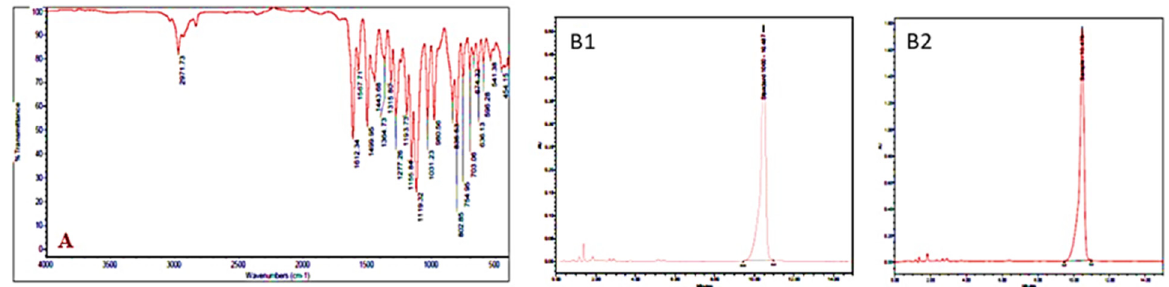
Figure 6. ( A ). FT-IR spectrum of fraction VII eluted from Desmostachya bipinnata chloroform extract. ( B1 ). HPLC analysis of standard compound; ( B2 ) HPLC analysis of fraction VII eluted from Desmostachya bipinnata chloroform extract.